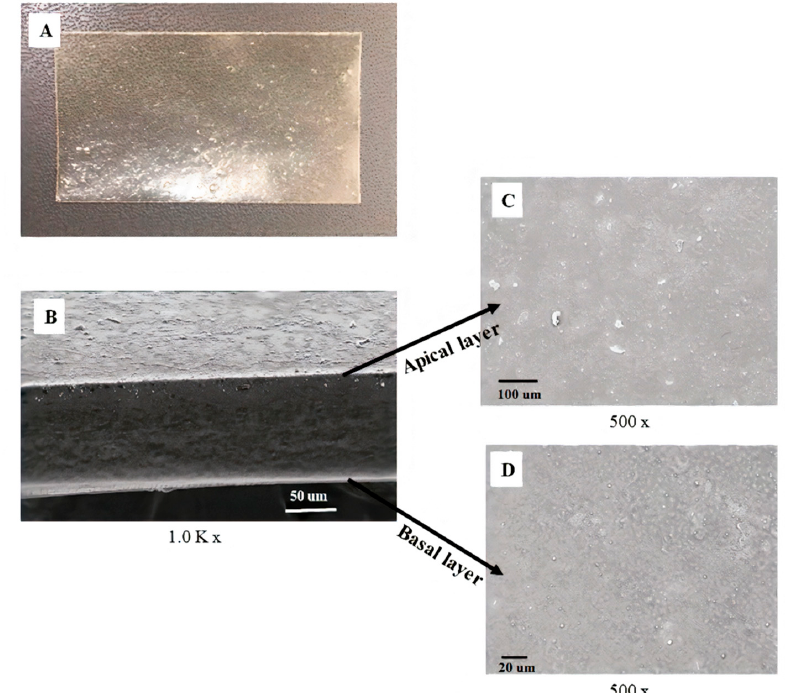
Figure 4 Figure 4. Structure of the bilayer film produced by hydrogel extension. The macroscopic image is observed in panel ( A ). Panels ( B – D ) show scanning electron microscopy of the mucoadhesive film ( A -film) with lidocaine HCl (basal layer), benzydamine HCl, and N -acetyl-L-cysteine (apical layer). The sideview image, 1.0K × , shows the bilayer and space between apical and basal layers ( B ). The frontal image 500 × shows the apical layer ( C ) and basal layer ( D